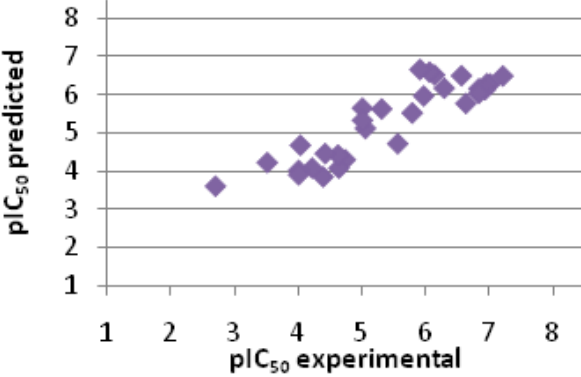
Figure 5. Correlation between predicted and experimental values of the activity for the test set ( R = 0.8937, n = 30).